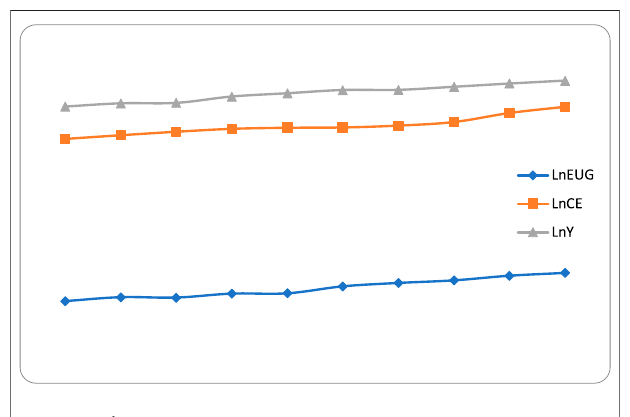
FIGURE 1 | Time series of lnEUG, lnCE, and